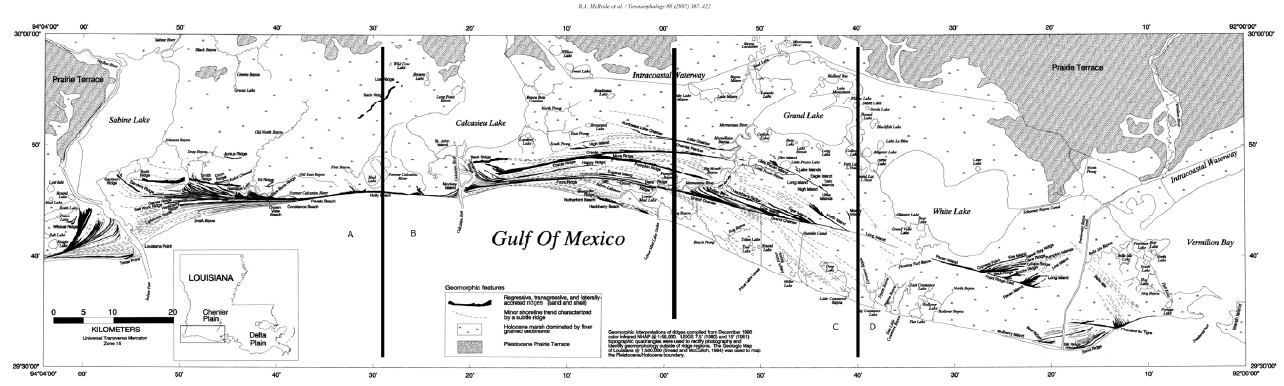
Figure 1. A map indicating the distribution of chenier ridges, shown in black bars, along the coast of Vermillion and Cameron Parishes. Adapted from McBride (2007) with permission from Elsevier. The lines and numbering represent divisions created for data